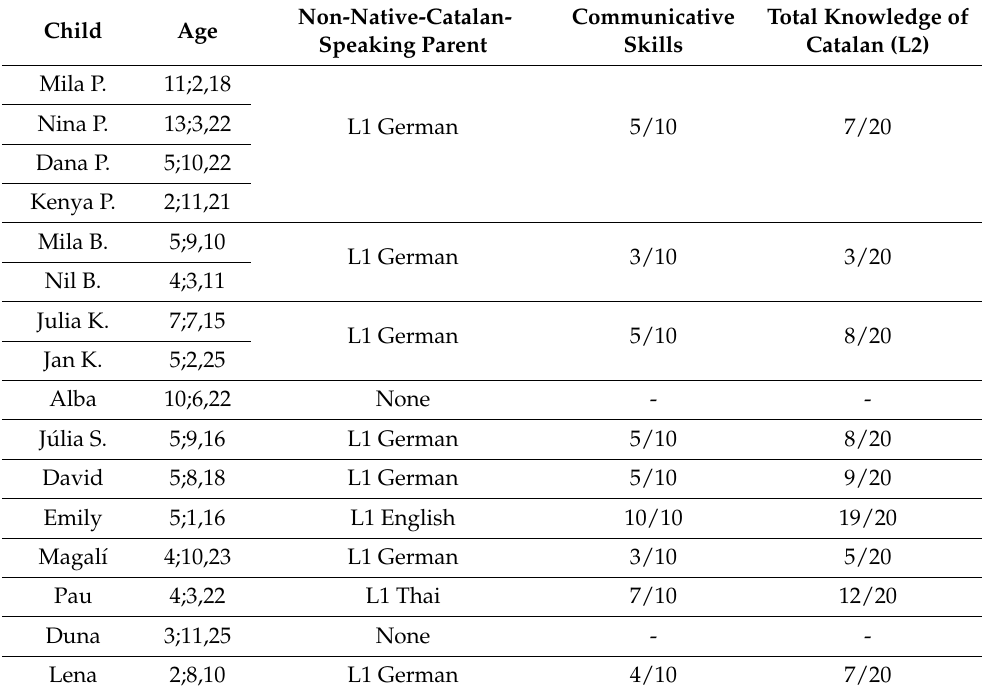
Table 8. Linguistic skills of the non-native-Catalan-speaking parents. Non-Native-Catalan- Communicative Child Age Speaking Parent